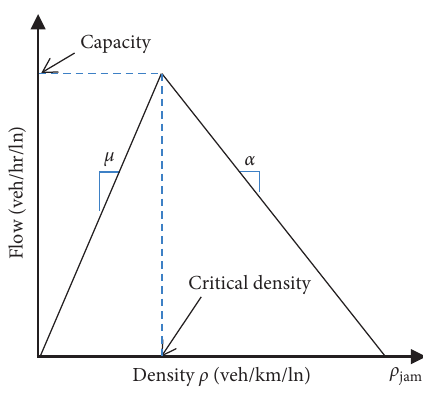
Figure 5: Fundamental Diagram used as input for CTM.